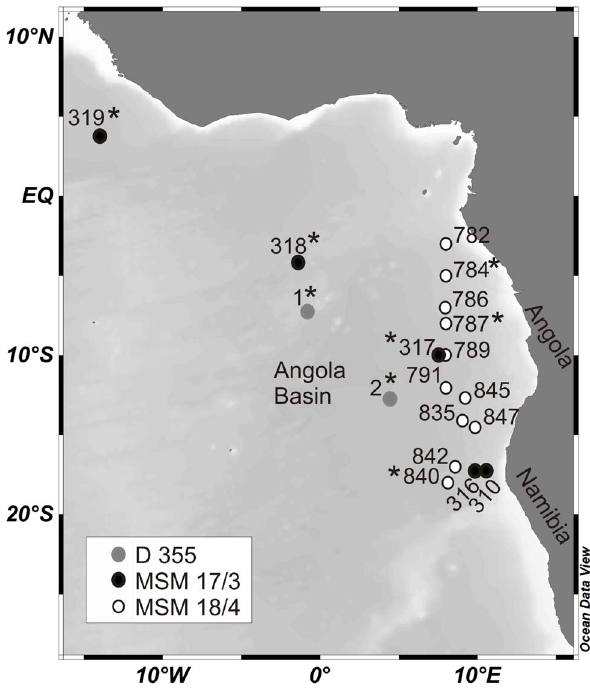
Figure 1. Sampling stations in the eastern tropical Atlantic Ocean. Copepods were sampled during three expeditions with RRS Discovery in 2010 (D355, gray circles) and with RV Maria S. Merian in 2011 (MSM 17/3, black circles and MSM 18/4, white circles). *=stations analysed for copepod abundance and species composition.